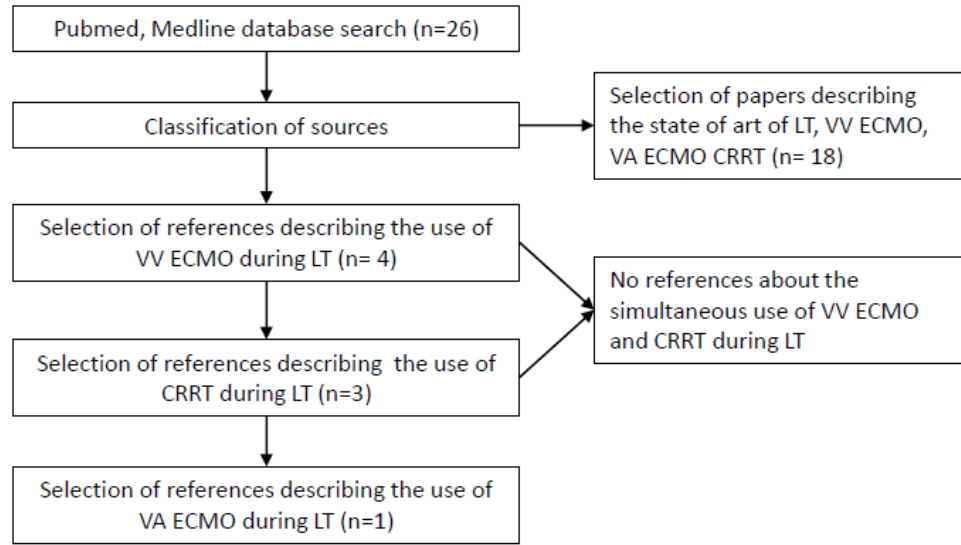
Figure 1. Selection process for references included. VV ECMO: Veno-Venous Extracorporeal Mem- brane Oxygenator; VA ECMO: Veno-Arterial Extracorporeal Membrane Oxygenator; CRRT: Con- tinuous Renal Replacement Therapy; LT: Liver Transplantation.